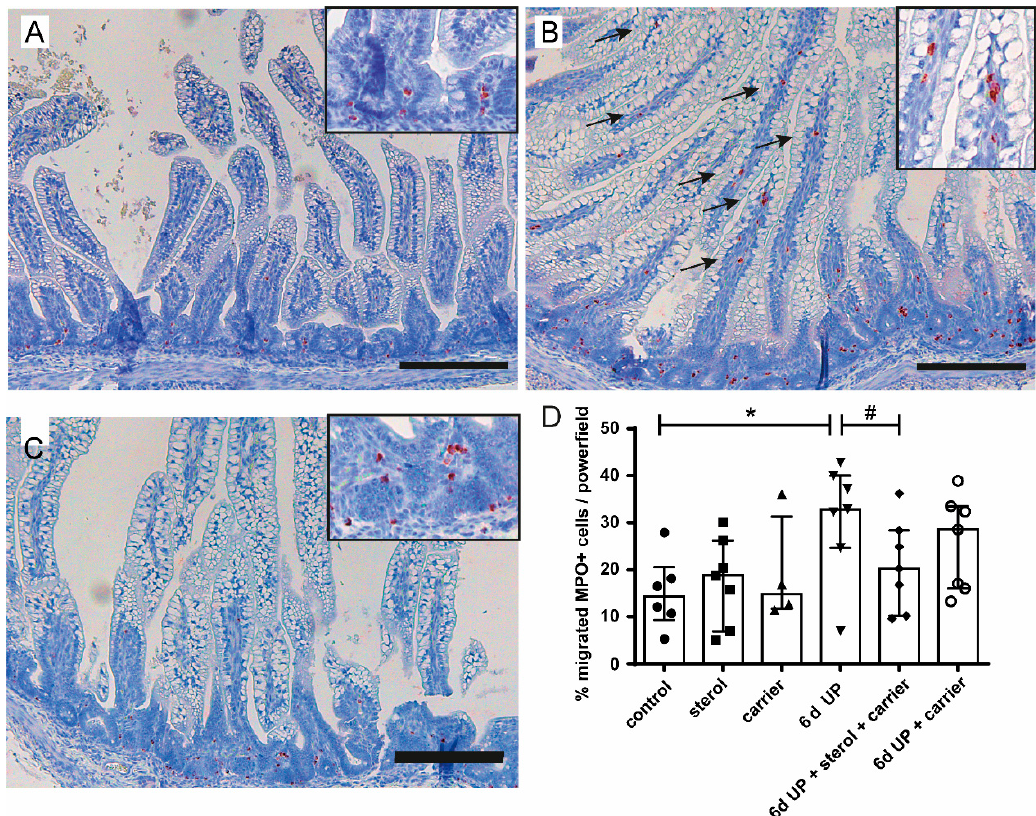
Figure 3. Immunohistochemical distribution of MPO-positive cells. ( A ) In control fetuses, MPO-positive cells were predominantly located in the lower crypt region. ( B ) After 6 d of UP exposure, the percentage of migrated MPO-positive cells (indicated by black arrows) increased compared to control fetuses. ( C ) An influx of MPO-positive cells in the villi tended to be prevented after treatment with plant sterols. ( D ) The total number of MPO-positive cells and the number of migrated MPO-positive cells were counted per high-power field, and the mean value of the count in five representative high-power fields is given. Scale bar indicates 200 µ m. * p < 0.05; # 0.05 < p < 0.10. Abbreviations: MPO, myeloperoxidase; UP, U. parvum .